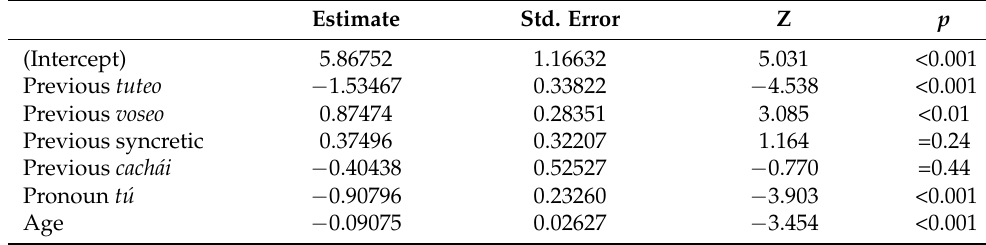
Table 5. Output of a generalized linear mixed effects model predicting tuteo.